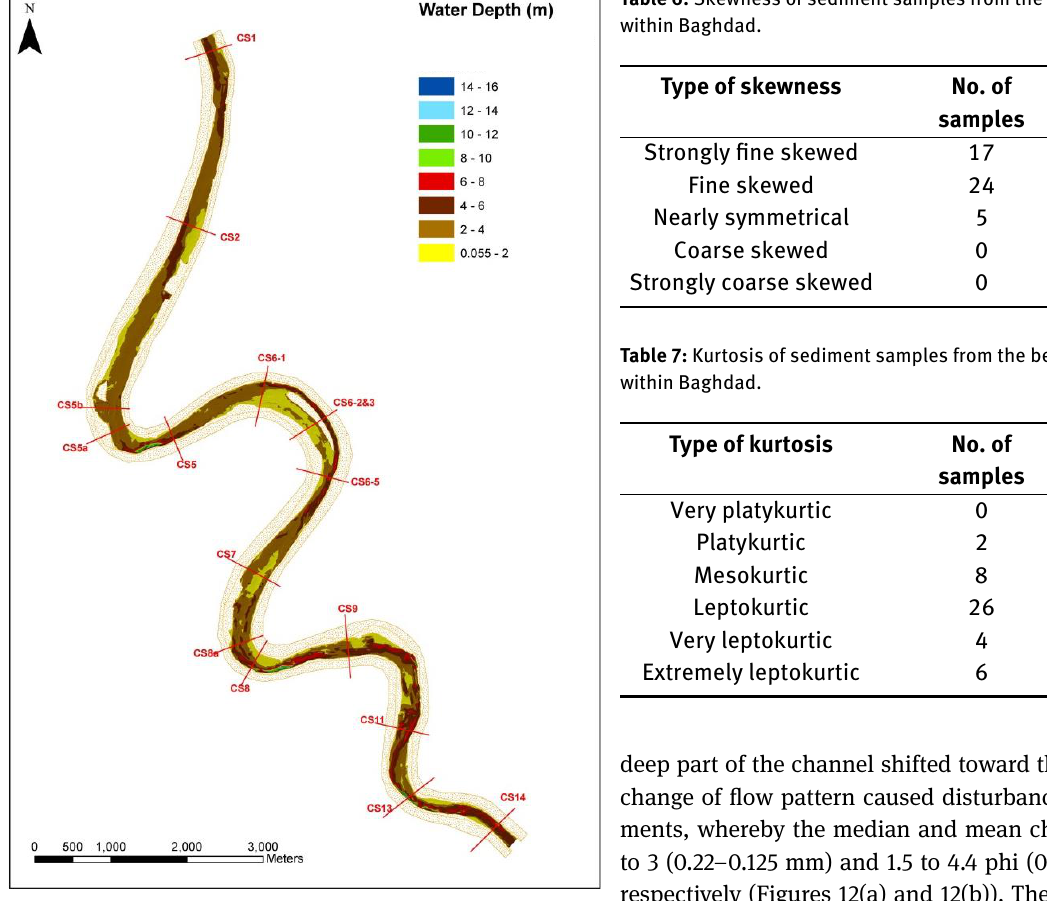
Figure 11. Water depths (500 m 3 /s discharge and 6.9 cm/km water surface slope). Figure 11: Water depths (500 m 3 /s discharge and 6.9 cm/km water surface slope). Table 5: Sorting of sediment samples from the bed of River Tigris within Baghdad.